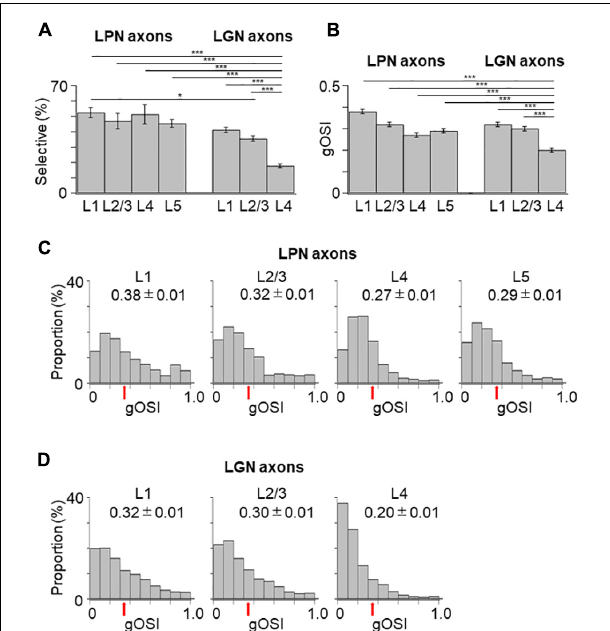
FIGURE 4 | Proportion of orientation-selective axons and distribution of gOSI of LPN and LGN boutons in V1. (A) The proportion of orientation-selective LPN and LGN boutons. The proportion of LGN boutons in the layer 4 was significantly different from that of LGN boutons in the remaining layers as well as that of LPN boutons in all the layers ( P ≤ 0.001, Mann–Whitney U -test with Bonferroni correction). The proportion of LGN boutons in the layer 2/3 was significantly different from that of LPN boutons in the layer 1 ( p = 0.012, Mann–Whitney U -test with Bonferroni correction) but no significant difference from layers 2/3, 4, and 5 ( p = 1, Mann–Whitney U -test with Bonferroni correction). The proportion of LGN boutons in the layer 1 was not significantly different from that of LPN boutons in all the layers (layer 1, p = 0.118; layers 2/3, 4 and 5, p = 1, Mann–Whitney U -test with Bonferroni correction). (B) The mean gOSI of responsive LPN and LGN boutons. gOSI of LGN boutons in the layer 4 was significantly lower than that of LGN boutons in the layers 1, 2/3, LPN axons in the layers 1, 2/3, 4, and 5 ( P ≤ 0.001, Mann–Whitney U -test with Bonferroni correction). gOSI of LGN boutons between the layers 1 and 2/3 ( p = 1, Mann–Whitney U -test with Bonferroni correction), and gOSI of LPN boutons among different layers were statistically not different (between the layers 1 and 2/3, p = 1; between the layers 1 and 4, p = 0.105; between the layers 1 and 5, p = 0.126; between the layers 2/3 and 4, p = 1; between the layers 2/3 and 5, p = 0.588; between the layers 4 and 5, p = 1, Mann–Whitney U -test with Bonferroni correction). (C) The distribution of gOSI of LPN boutons in the layer 1 (left, n = 562 boutons from six mice, 11 FOVs), layer 2/3 (second from left, n = 313 boutons from six mice, 7 FOVs), layer 4 (second from right, n = 458 boutons from five mice, 8 FOVs), and layer 5 (right, n = 391 boutons from two mice, 9 FOVs). (D) The distribution of gOSI of LGN boutons in the layer 1 (left, n = 2,924 boutons from 37 mice, 123 FOVs), layer 2/3 (second from left, n = 2,818 boutons from 36 mice, 97 FOVs), and layer 4 (second from right, n = 1,722 boutons from 30 mice, 98 FOVs). Arrows (B,C) indicate the threshold (gOSI = 0.33) for sharply orientation-selective boutons. gOSI, global orientation-selective index; LPN, lateral posterior nucleus; LGN, lateral geniculate nucleus; V1, primary visual cortex; FOV, field-of-view. * P ≤ 0.05; *** P ≤ 0.001. The data of LGN axons are re-use from the previous publication (Kondo and Ohki, 2016).